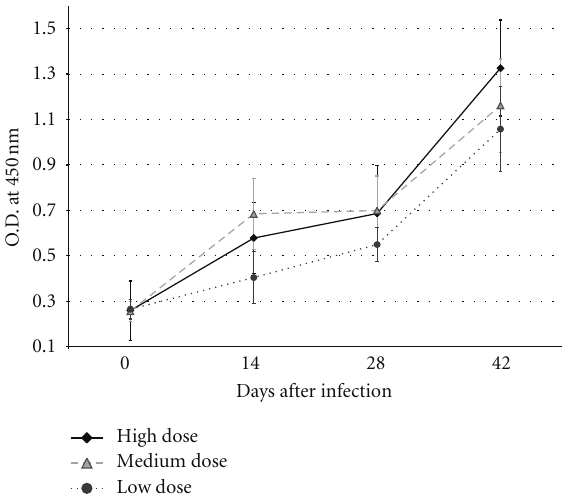
Figure 1: Total IgG levels along the evaluation period. Mean and S.D. of OD 450nm for groups infected with high (200,000 MT), medium (20,000 MT) and low (2,000 MT) parasite doses, showing a constant increase in antibody levels in dogs on days 0, 14, 28 and 42 post infection. No statistical di ff erences were found between groups ( P > 0 . 05).